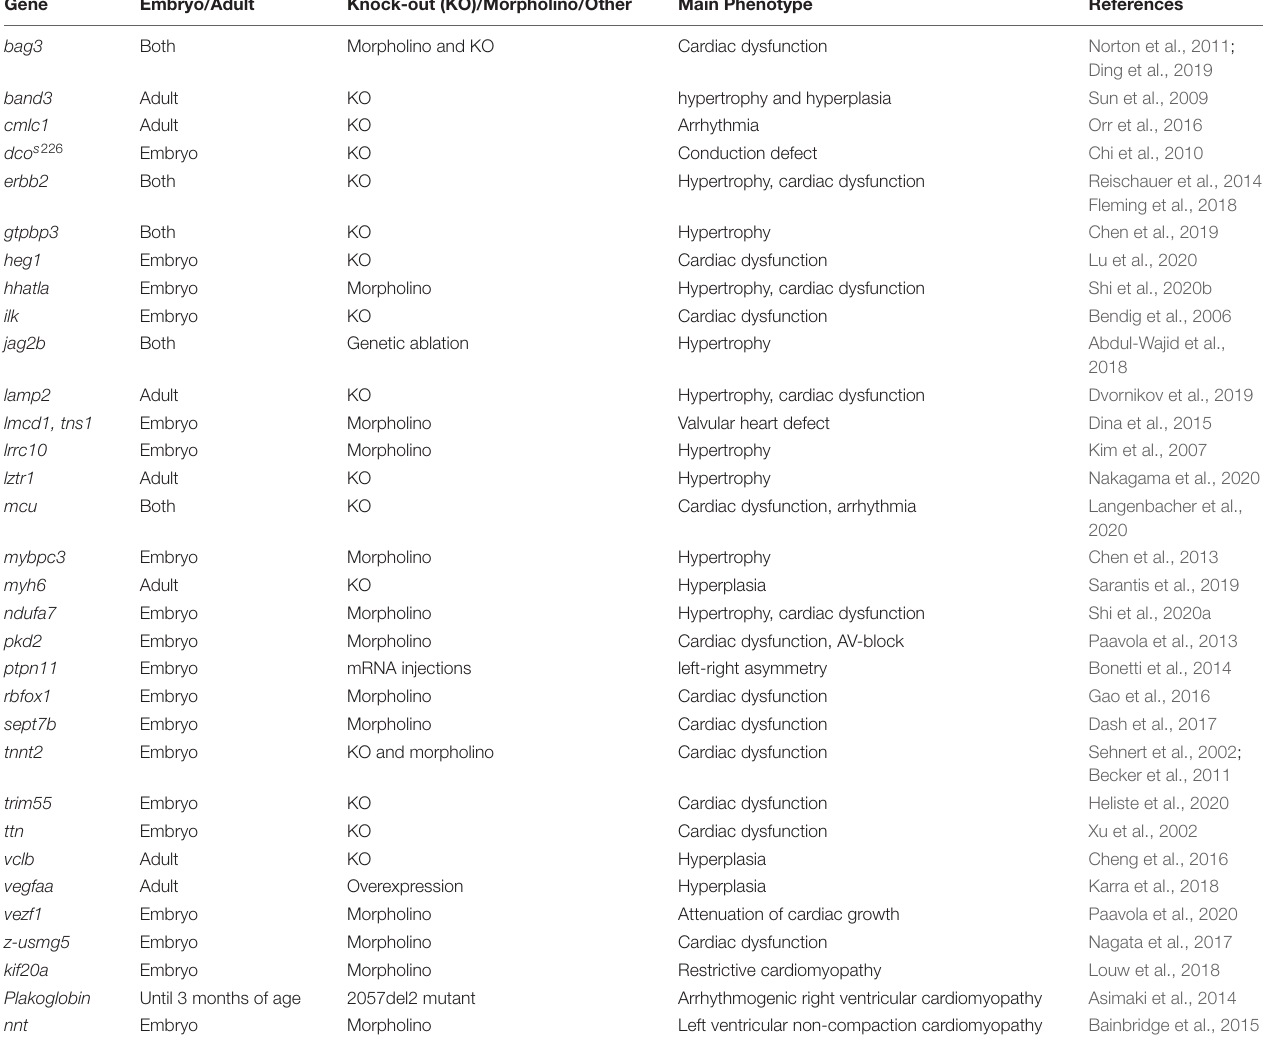
TABLE 2 | Genetic models of heart failure.